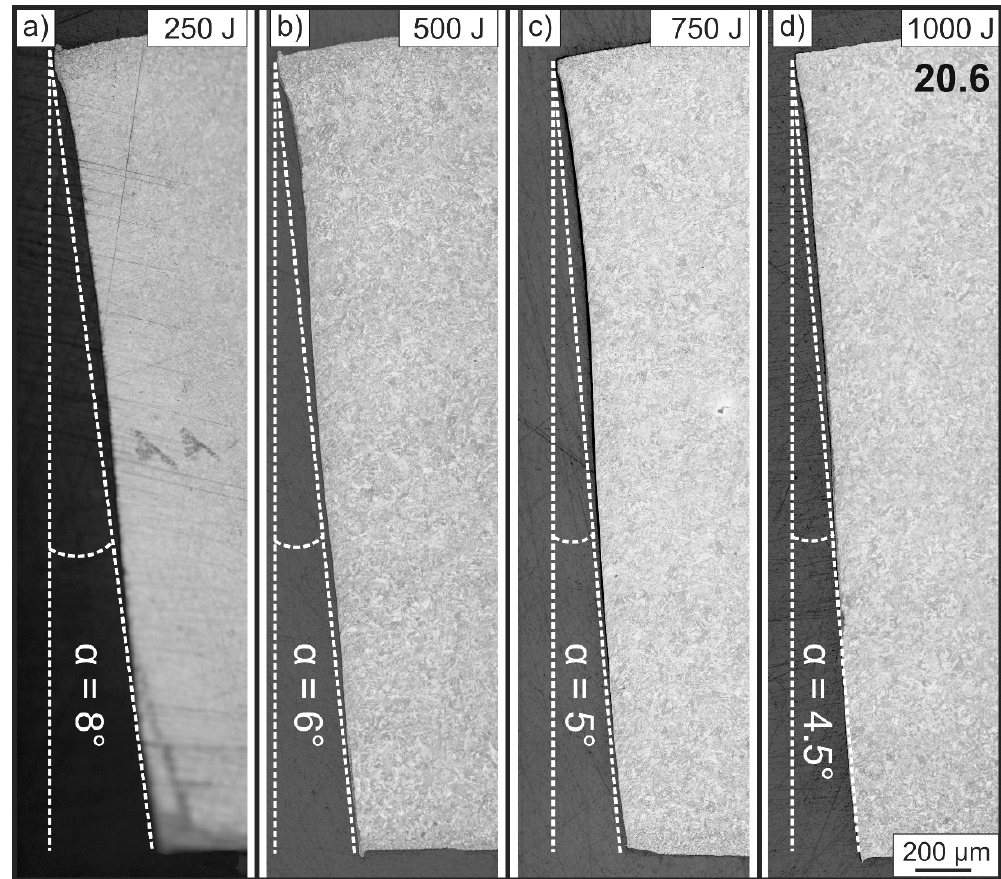
Figure 7. The blanked surface of the sheet is shown for a relative clearance of 10% (specimen 20.6) and varying impact energies from ( a ) 250 J, ( b ) 500 J, ( c ) 750 J to ( d ) 1000 J. The fracture angle α becomes smaller with increasing impact energy.